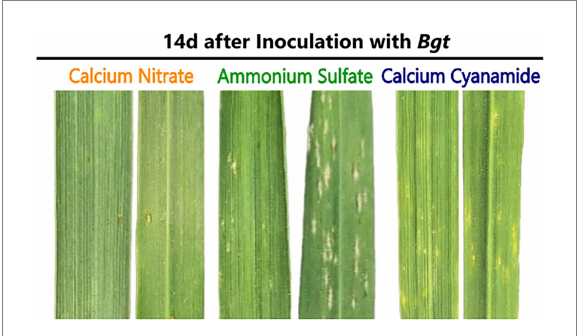
FIGURE 2 Powdery mildew infestation on the upper (left) and lower (right) surface of winter wheat leaves when fertilized with calcium nitrate, ammonium sulfate, or calcium cyanamide, 14 days (d) after Bgt